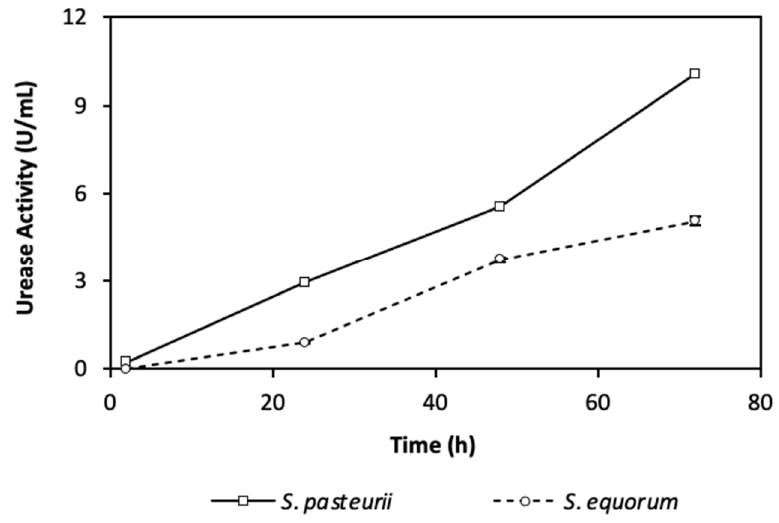
Figure 3. Urease activity of S. pasteurii and S. equorum during growth assays.